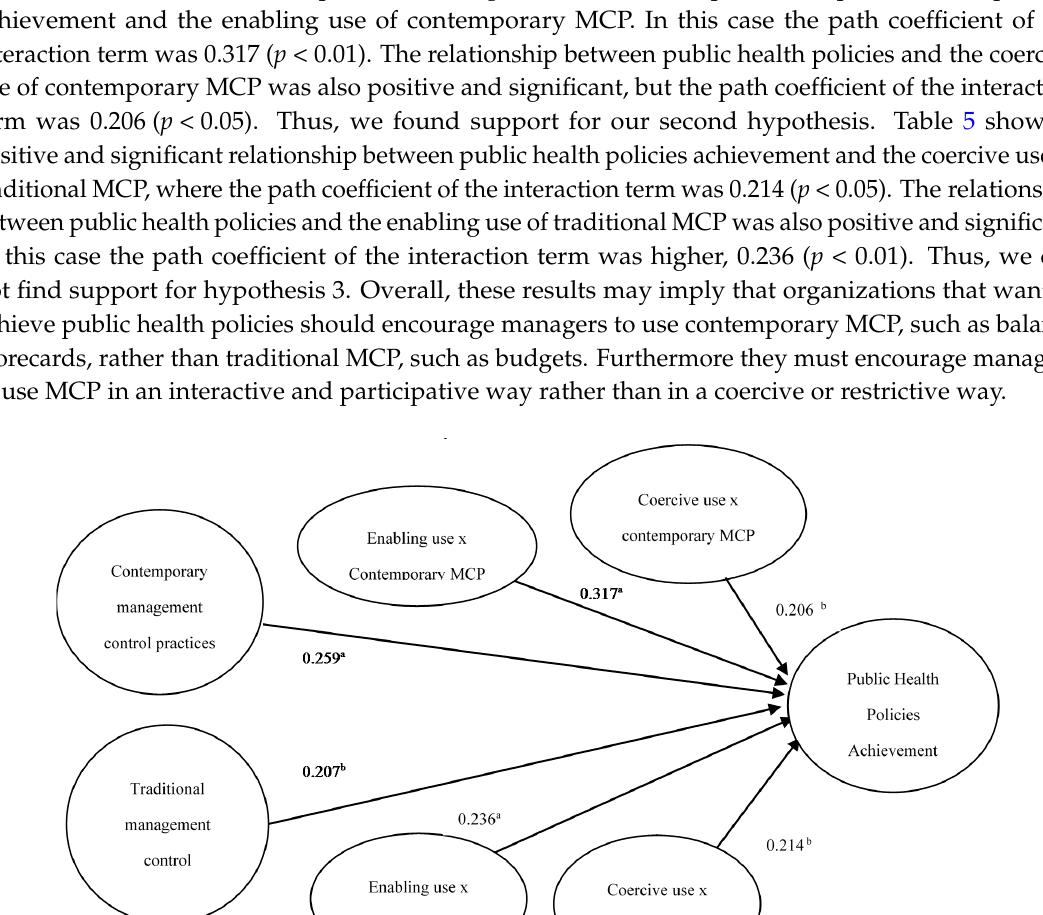
Table 4. Correlations among research variables.